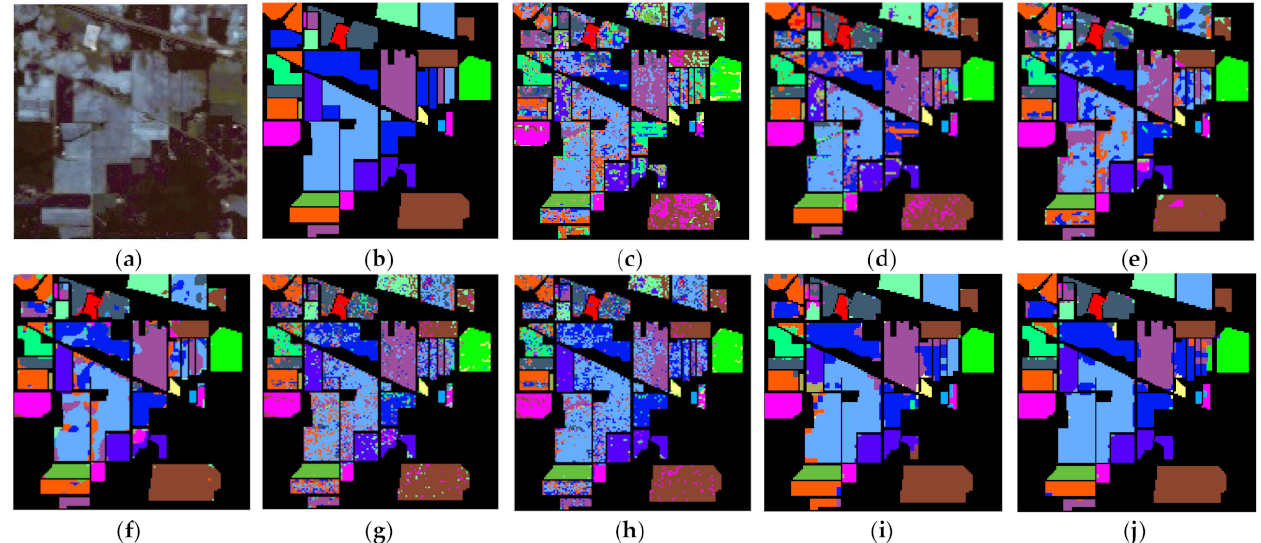
Figure 11. Classification maps obtained by different methods on Indian Pines Dataset. ( a ) False-color